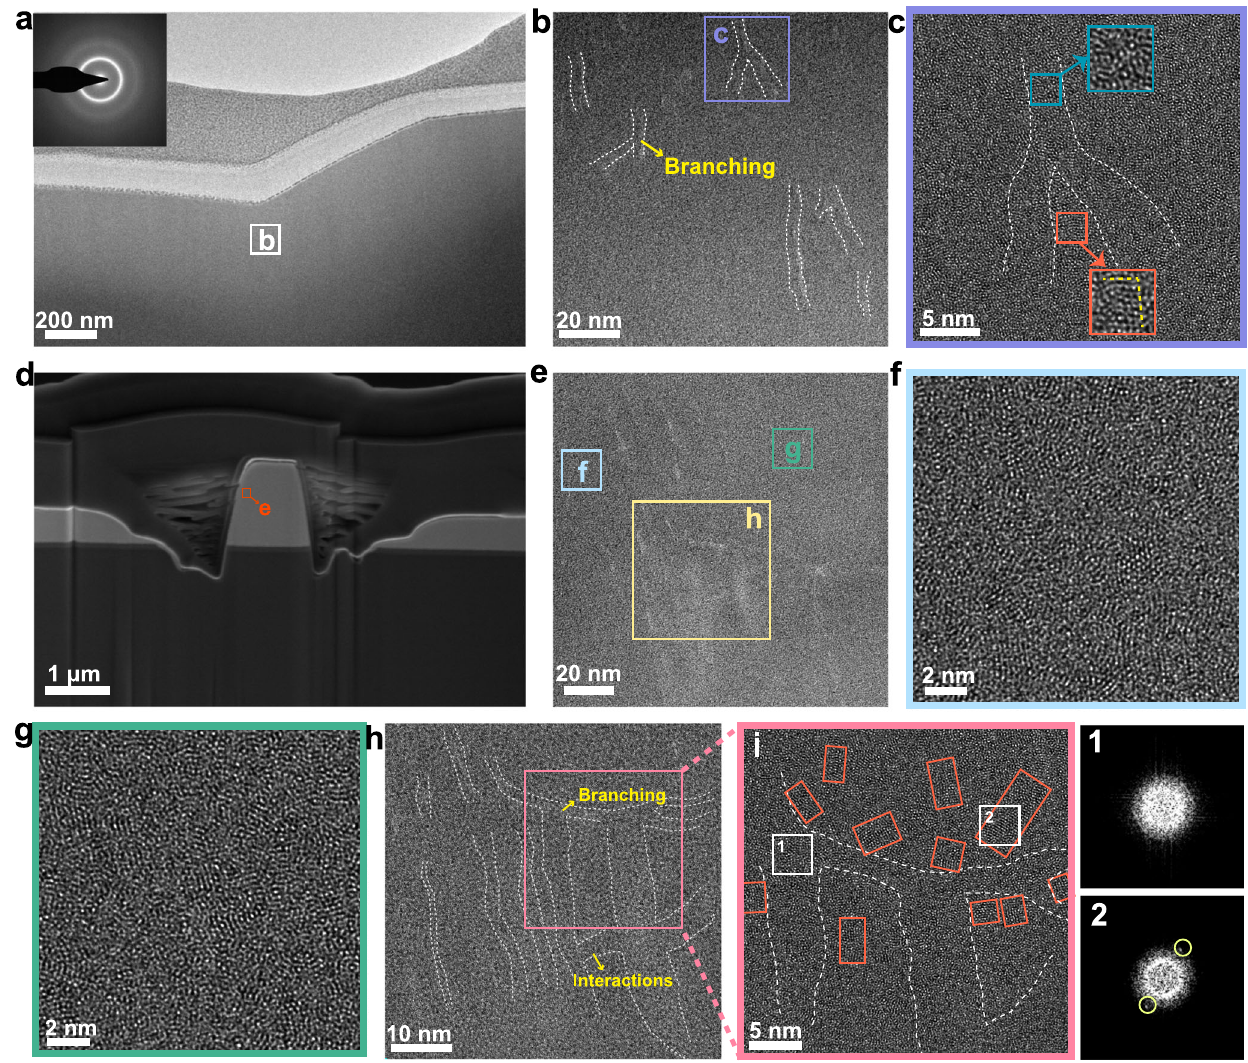
Fig. 5 | Experimental observations describing deformation behavior in para- crystalline Zr 15 Nb 14 Hf 22 Ta 22 Mo 24 Pt 3 HEA. a TEM image taken from the cross- sectionedindentedregion shows thatthereisno macroscopicshearband(SB)can be captured in the deformed paracrystalline HEA. Inset is the corresponding selectedarea electron diffraction (SAED) image. b HRTEM image taken from white square in( a ),revealing the zigzagfeatureand branching of nanoscale SBs(marked with white dashed lines). c Enlarged HRTEM image in b shows the disordered featureinsideSB(green square) and the crystalline featureatthe bifurcation ofSB (orange square). d SEM image of the compressed micropillar by focused ion beam (FIB) milling. e HRTEM image taken from the orange square in ( d ), suggesting the